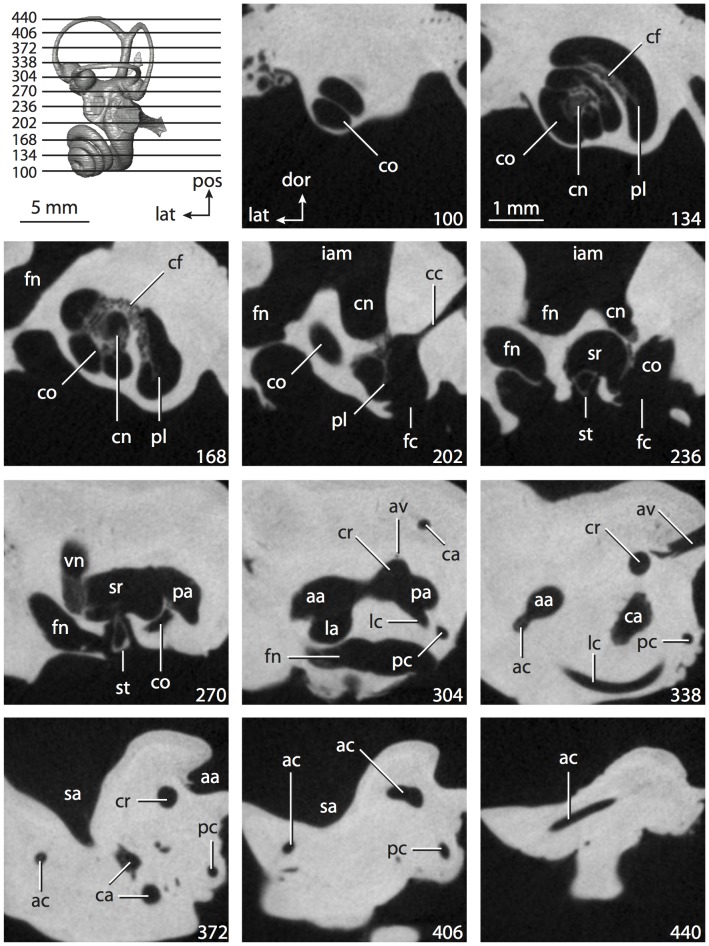
CT slices through ear region ofSus scrofa.Abbreviations listed at the end of the Materials and Methods section.